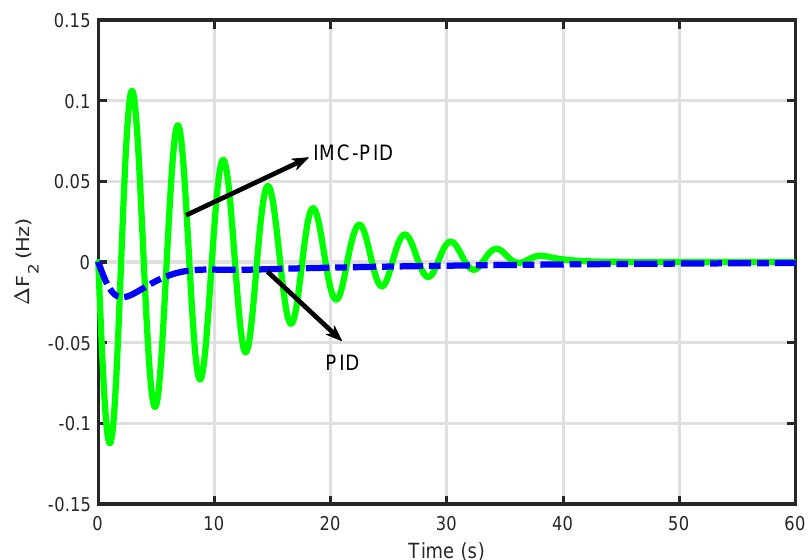
Figure 10. Frequency deviation in area 2 with the IMC-PID and PID controllers (case c-II).